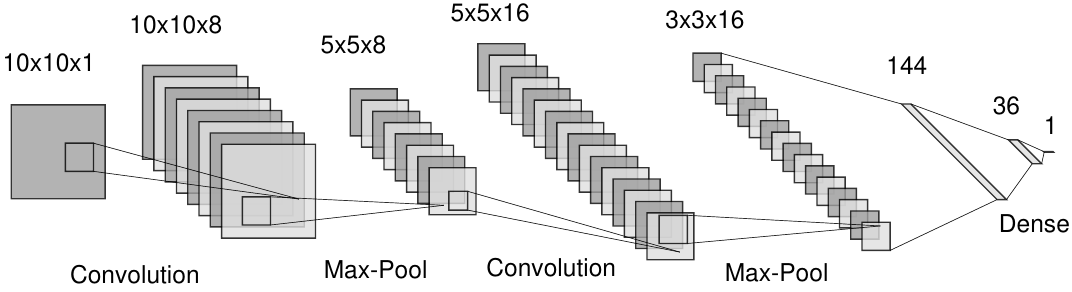
Table 2 . Architecture of Convolutional Neural Network.